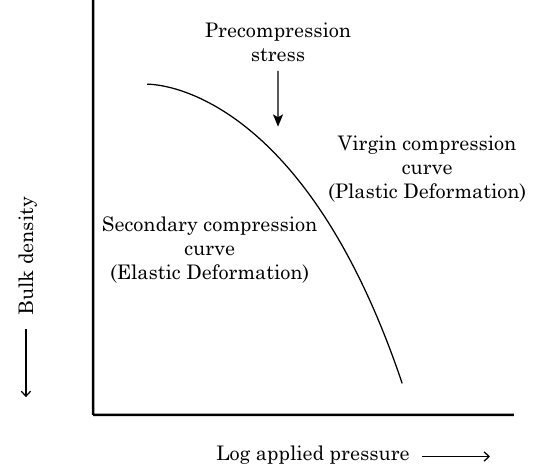
Figure 1. Soil compression curve. Adapted from Dias Junior